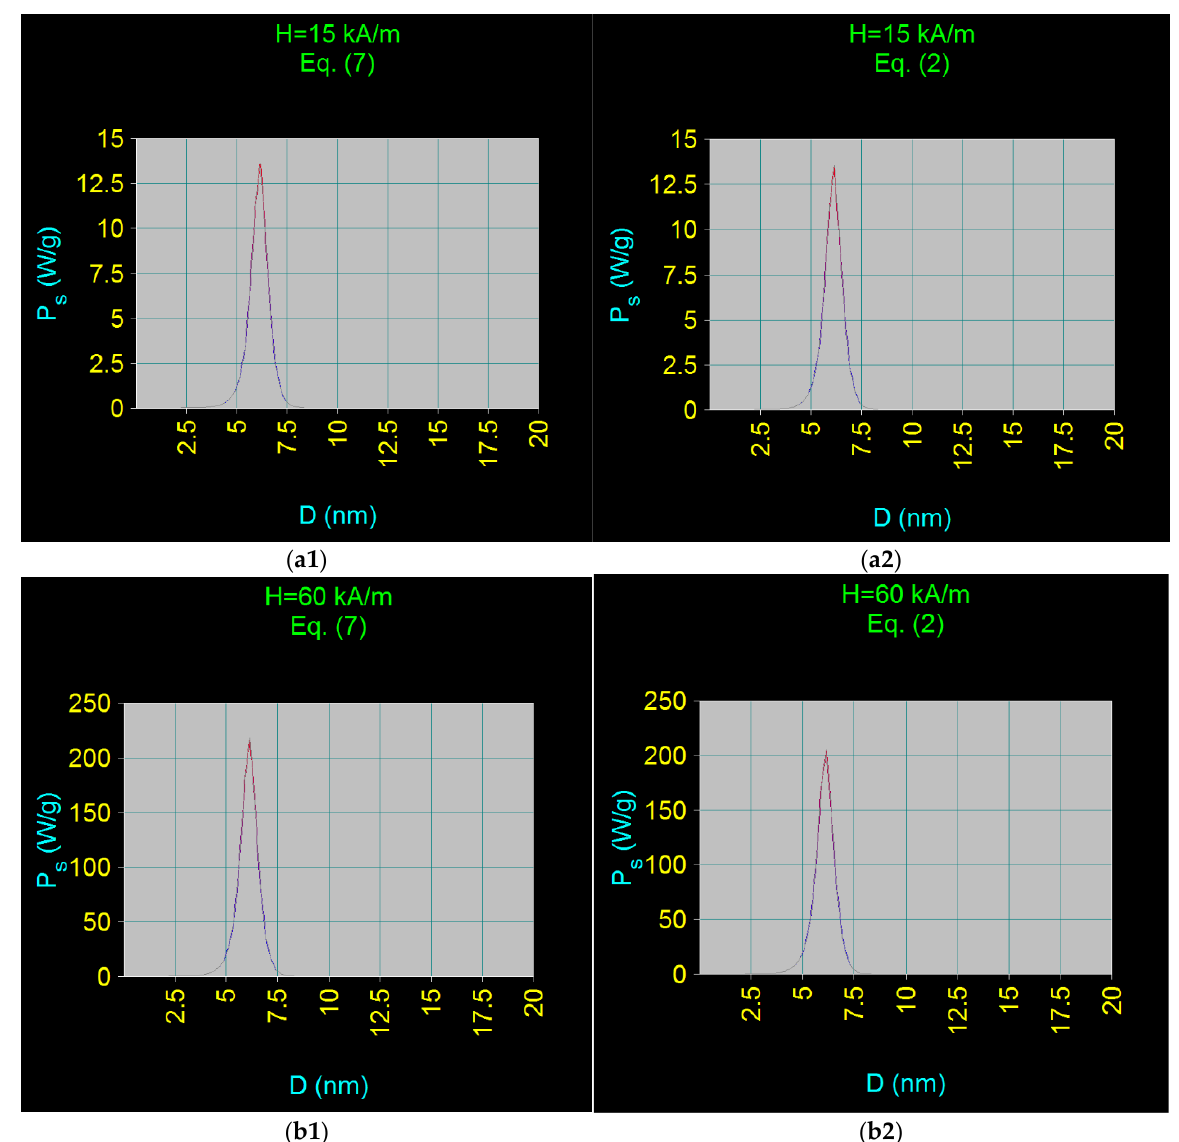
Figure 4. The specific loss power (Ps) as a function of CoFe 2 O 4 nanoparticles diameter (D) calculated at the magnetic field frequency (f) of 500 kHz, using: ( a1 ) Equation (7) and the magnetic field amplitude H = 15 kA/m, ( b1 ) Equation (7) and H = 60 kA/m, ( a2 ) Equation (2) and H = 15 kA/m, and ( b2 ) Equation (2) and H = 60 kA/m.